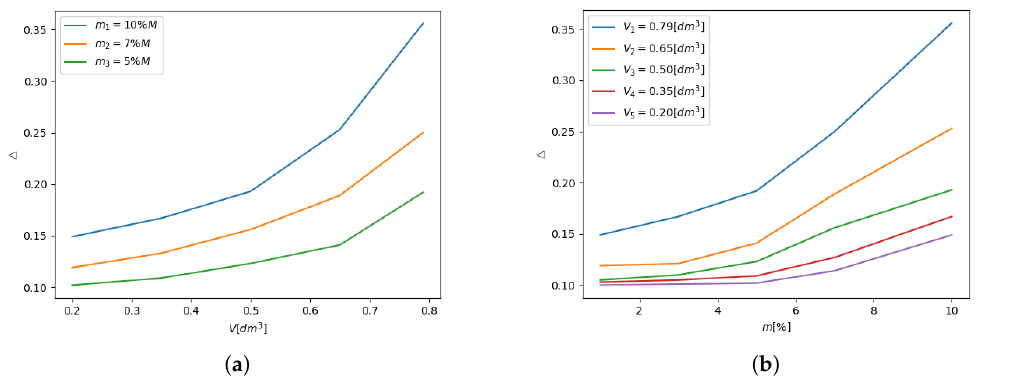
Figure 10. Logarithmic damping decrement. ( a ) Variable particles mass; ( b ) Variable container